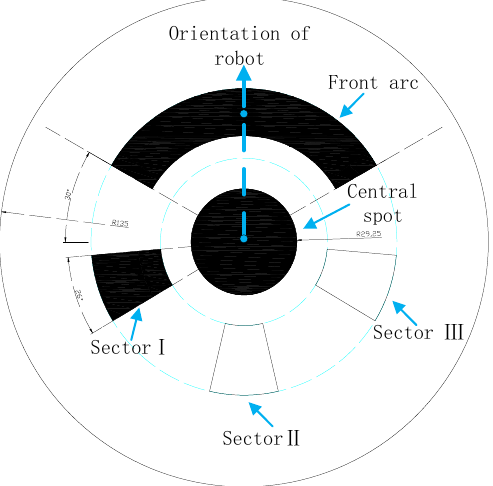
Figure 10. The location identifier labeled at the top of the robot.